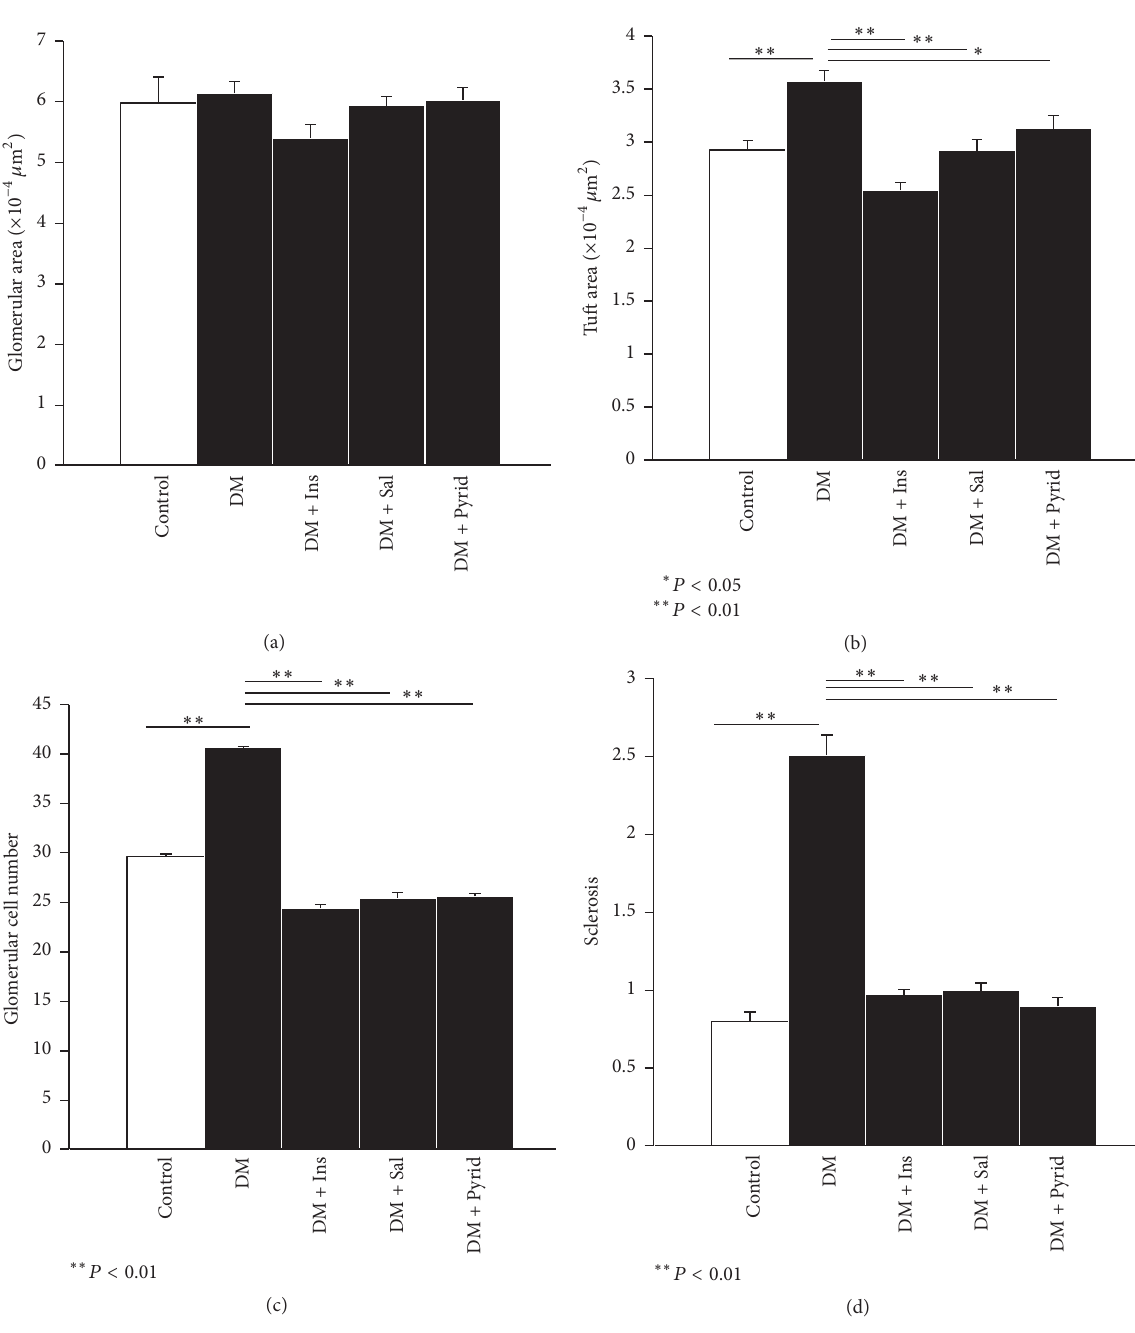
Figure 4: Histological evaluations of kidneys. Glomerular area (a), tuft area (b), glomerular cell number (c), and sclerosis indices (d) are shown. Nondiabetic control (Control) ( 𝑛 = 8 ), diabetic mice without treatment (DM) ( 𝑛 = 19 ), diabetic mice with insulin treatment (DM + Ins) ( 𝑛 = 8 ), diabetic mice with salicylate treatment (DM + Sal) ( 𝑛 = 12 ), and diabetic mice with pyridoxamine treatment (DM + Pyrid) ( 𝑛 = 15 ). Values are mean ±